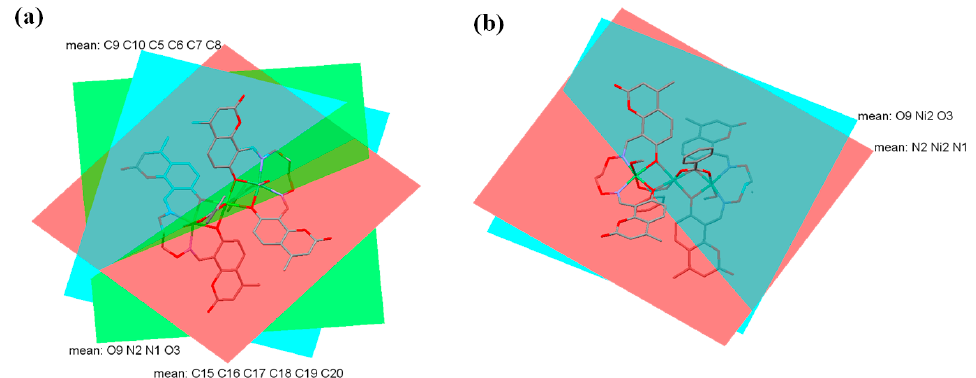
Figure 11. ( a ) View of the dihedral angles between the benzene rings and the N 2 O 2 basal plane of complex 3 ; ( b ) View of the dihedral angles between the planes NiN 2 and NiO 2 of complex 3 .